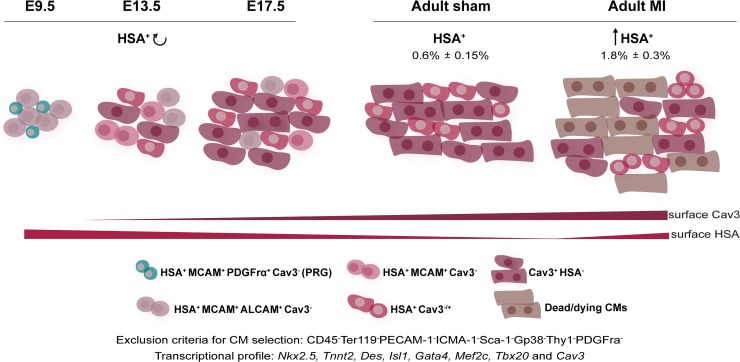
HSA is as a transversal marker of immature CMs.The combined use of surface marker analysis with single-cell transcriptional profiling allowed identifying different subsets of CMs (expressing Nkx2.5, TnnT2, Des, Isl1, Gata4, Mef2c, and Tbx20) in the murine heart. Less mature CMs (Tnnt+Cav3−) express HSA, MCAM, and ALCAM and progressively lose these markers, maintaining the expression of HSA. Cav3 transcripts are, however, detected in all CM subsets. A subset of CM PRGs (HSA+ALCAM+PDGFrα+) was found at E 9.5 and persisted in the At of E 13.5 and E 17.5 hearts (not represented). HSA+ CMs dramatically decrease around birth, coinciding with an increase in quiescent and binucleated Cav3+ cells, first detected at E 17.5. The adult myocardium is composed of 2 main CMs subsets: mononucleated HSA+Cav3+ and mono- and bi- nucleated Cav3+ CMs. Upon MI, HSA+ CMs frequency increases, and a small percentage of these is proliferating. Throughout cardiac maturation, proliferative CMs (↻) were only detected within the HSA+ compartment. Detailed information can be found in the text. ALCAM, activated leukocyte cell adhesion molecule; At, atria; Cav3, Caveolin 3; CD45, cluster of differentiation 45; CM, cardiomyocyte; E, embryonic day; Gp38, glycoprotein 38; HSA, heat stable antigen; ICAM-1, intercellular adhesion molecule 1; MCAM, melanoma cell adhesion molecule; MI, myocardial infarction; PDGFrα, platelet derived growth factor receptor alpha; PECAM-1, platelet/endothelial cell adhesion molecule 1; PRG, progenitor; Sca-1, stem cells antigen 1; Ter119, lymphocyte antigen 76 clone TER-119; Thy1, thymus cell antigen 1; Tnnt, troponin T.